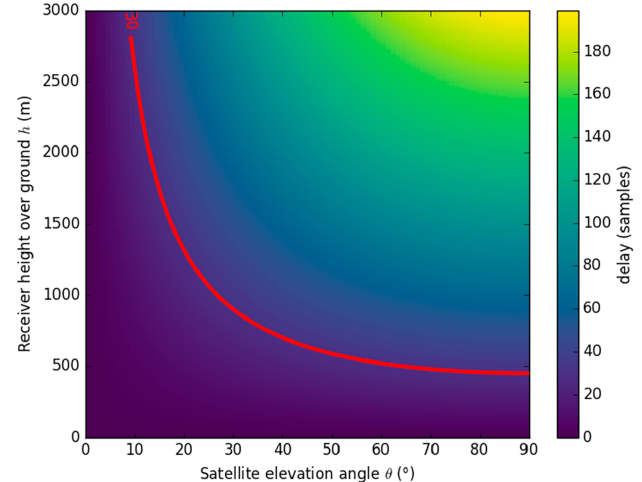
Figure 8. Delay between direct and reflected signals for various elevation angles and aircraft height. In the case of the current GLORI processing, all the area below the 30 sample red contour line can be subject to contamination by the direct signal.